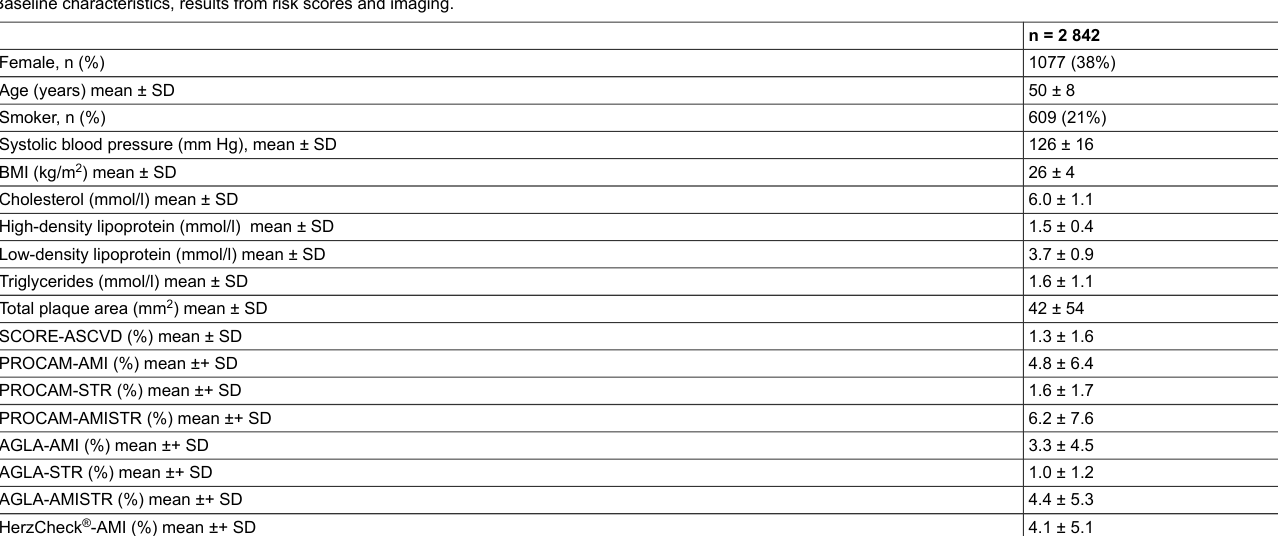
Table 1: Baseline characteristics, results from risk scores and imaging.